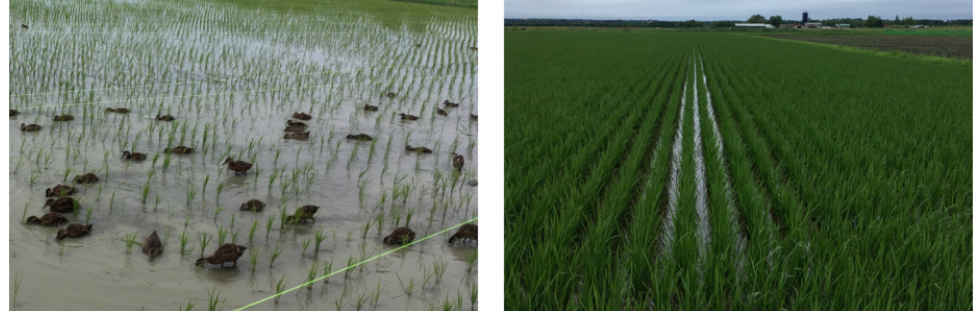
Figure 1. Mallards for rice–duck farming ( left ). After some growth of rice plants ( right ), mallards are hidden by the plants. Detecting mallards visually would be extremely